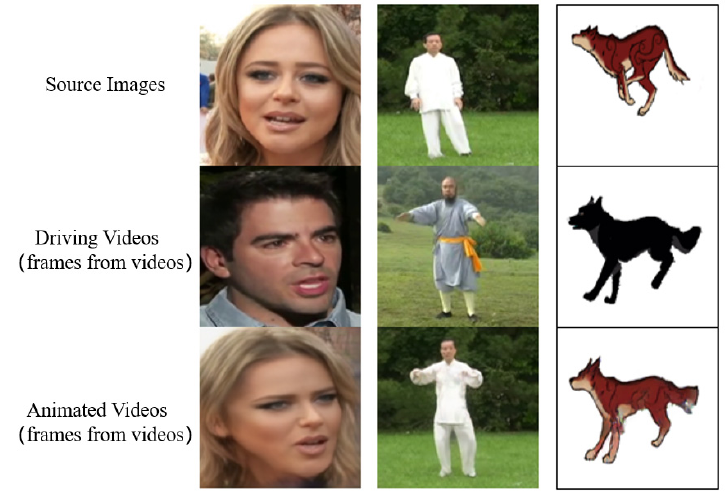
Figure 1. Our method animates still source images.